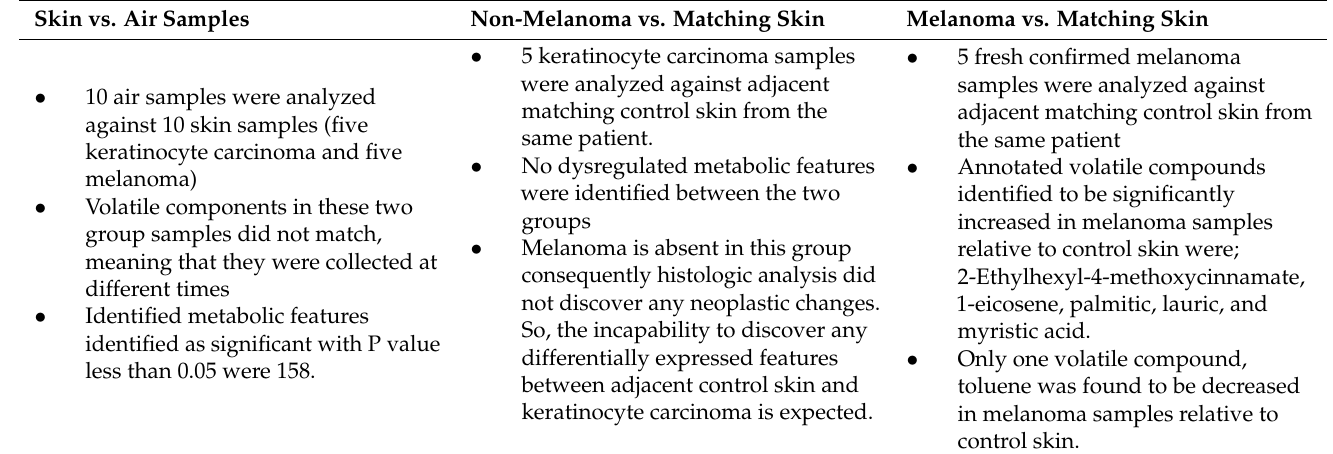
Table 4. Comparison of metabolomic signature between three groups: skin vs. air samples, ker- atinocyte carcinoma vs. matching skin and melanoma vs. matching skin. Skin vs. Air